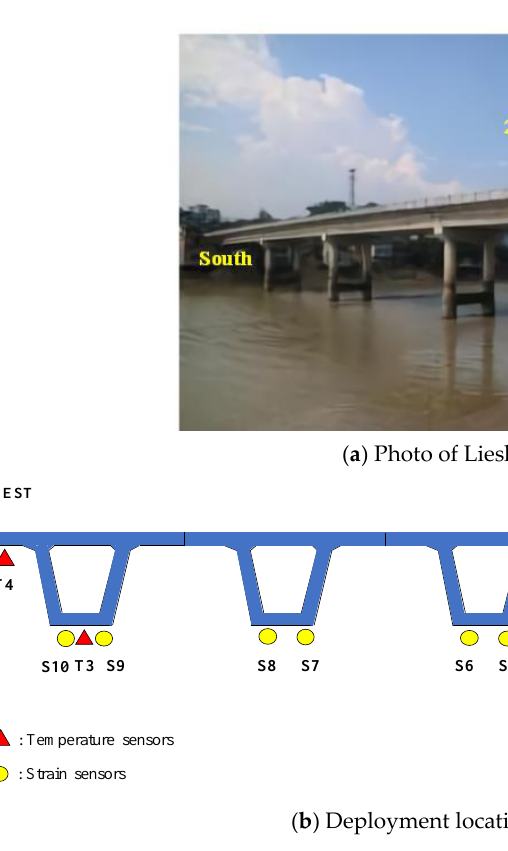
Figure 1. Photo of Lieshihe River Bridge and deployment locations of sensors.